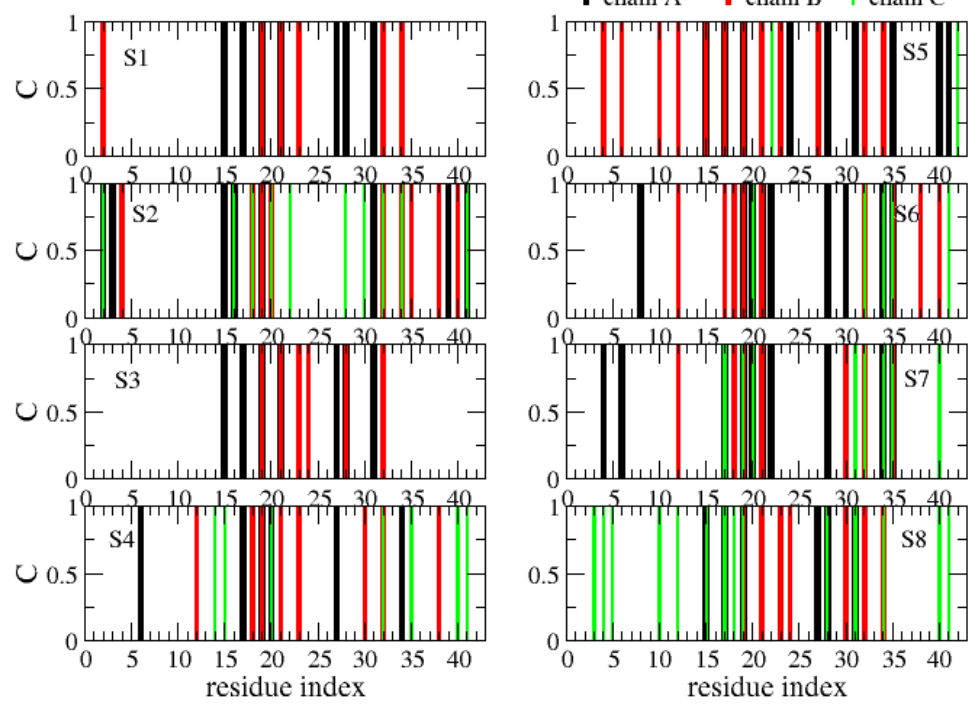
Figure 8. Contact between each A β 42 chain (A, B, C) and cholesterols. Shown are results for each energy minimum Si (i = 1 . . . 8). One A β 42 side-chain and one cholesterol molecule are considered in free energy minimum Si (i = 1…8). One A β 42 side-chain and one cholesterol molecule are considered in contact if there is at least one intermolecular distance below 0.45 nm. contact if there is at least one intermolecular distance below 0.45